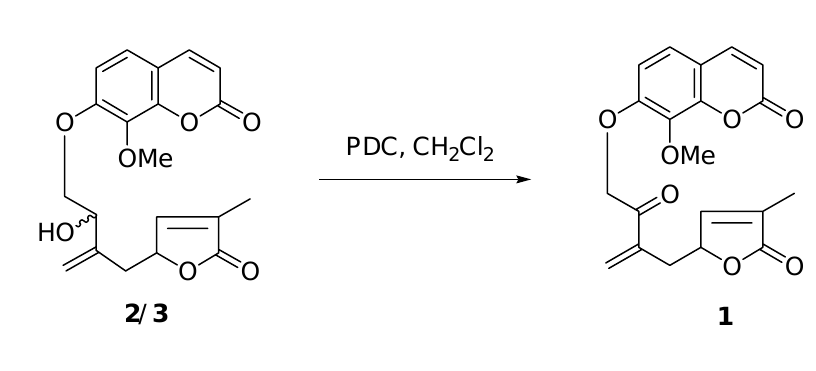
Figure 2. Oxidation of 2 / 3